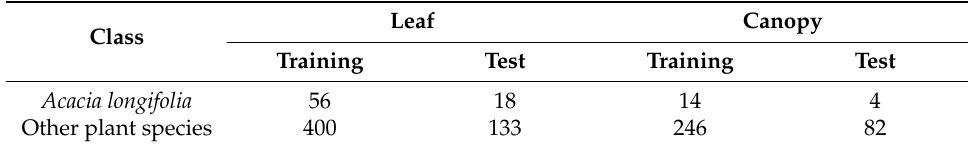
Table 2. Overview of the number of spectral samples for Acacia longifolia and other species used for training and testing at leaf and canopy level. Training samples of the minority class A. longifolia were up-sampled during resampling to match the majority class size and account for class imbalance. Leaf Canopy Class Training Test Training Test Acacia longifolia 56 18 14 4 Other plant species 400 133 246 82